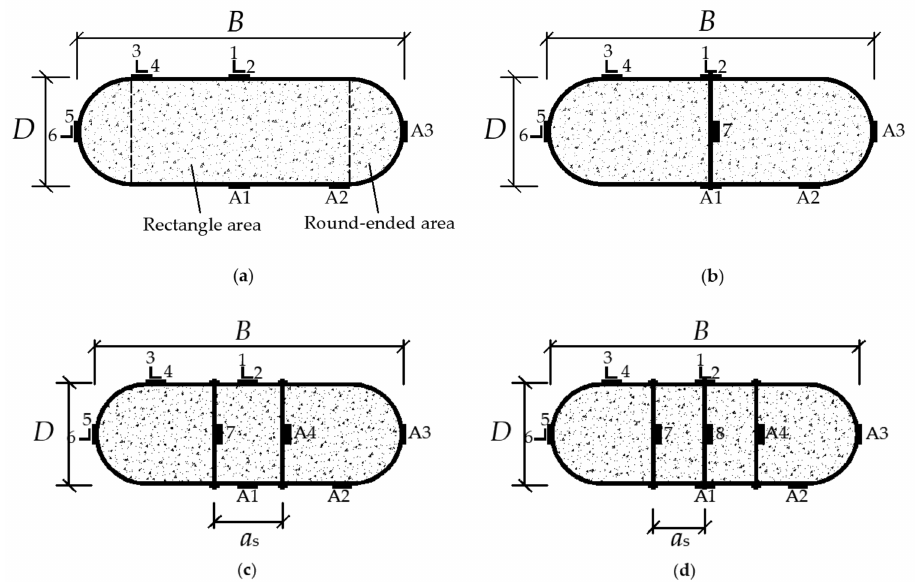
Figure 1. The dimension and the setting of tie bars of the specimens: ( a ) Non-tie bars; ( b ) Single limb of tie bars; ( c ) Two limbs of tie bars; ( d ) Three limbs of tie